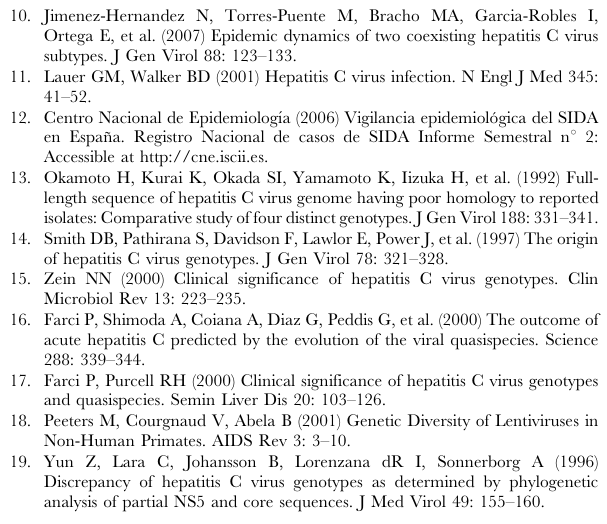
Table S3 Summary of Mann-Whitney tests for differences in recombination frequency between clinical groups considered in this